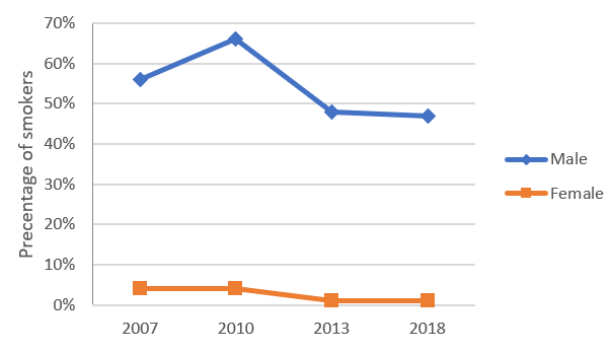
Figure 3. Domestic Cigarette